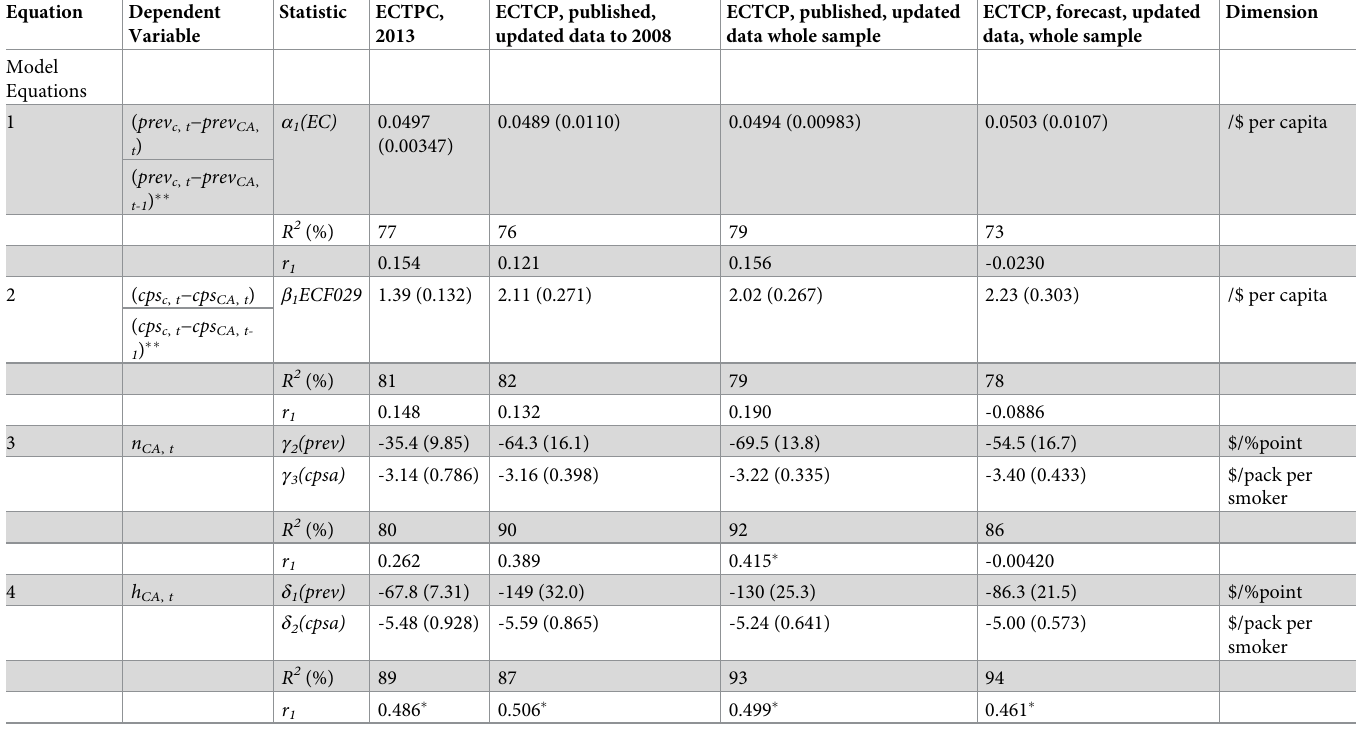
Table 1. Estimated California smoking prevalence, cigarettes per capita, and per capita healthcare